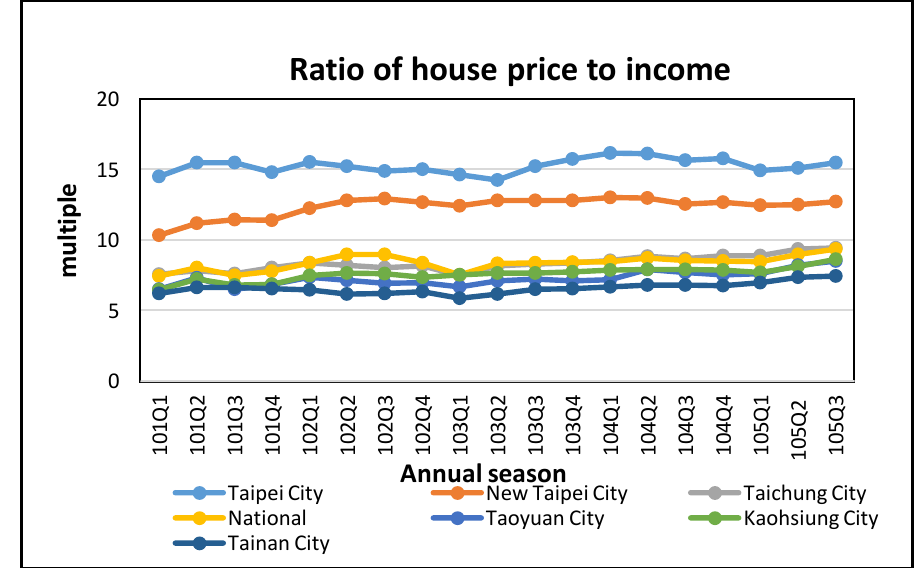
Figure 1: Ratios of house price to income from Q1, 2012 to Q3, 2016